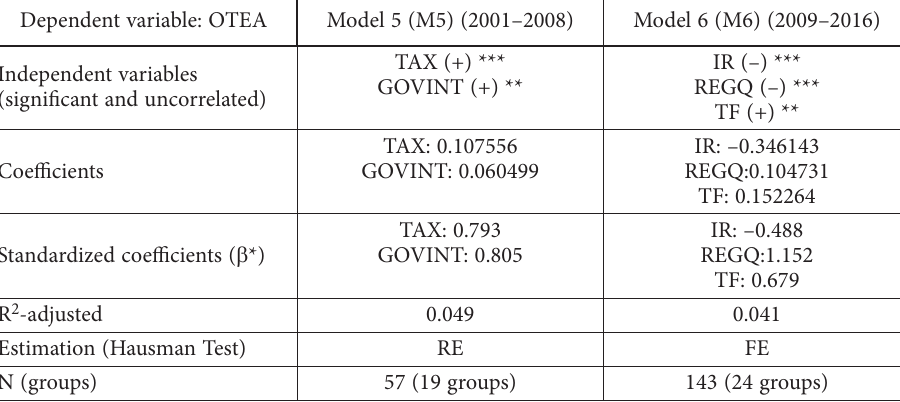
Table 6. Explanatory exploratory models of TEA by OTEA